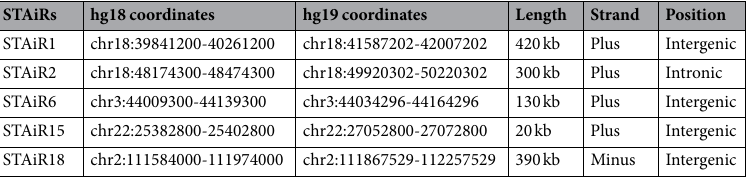
Table 1. Selected STAT3-induced ncRNAs (STAiRs). Chromosomal coordinates and lengths of the transcribed regions are given referring to human genome hg18 and